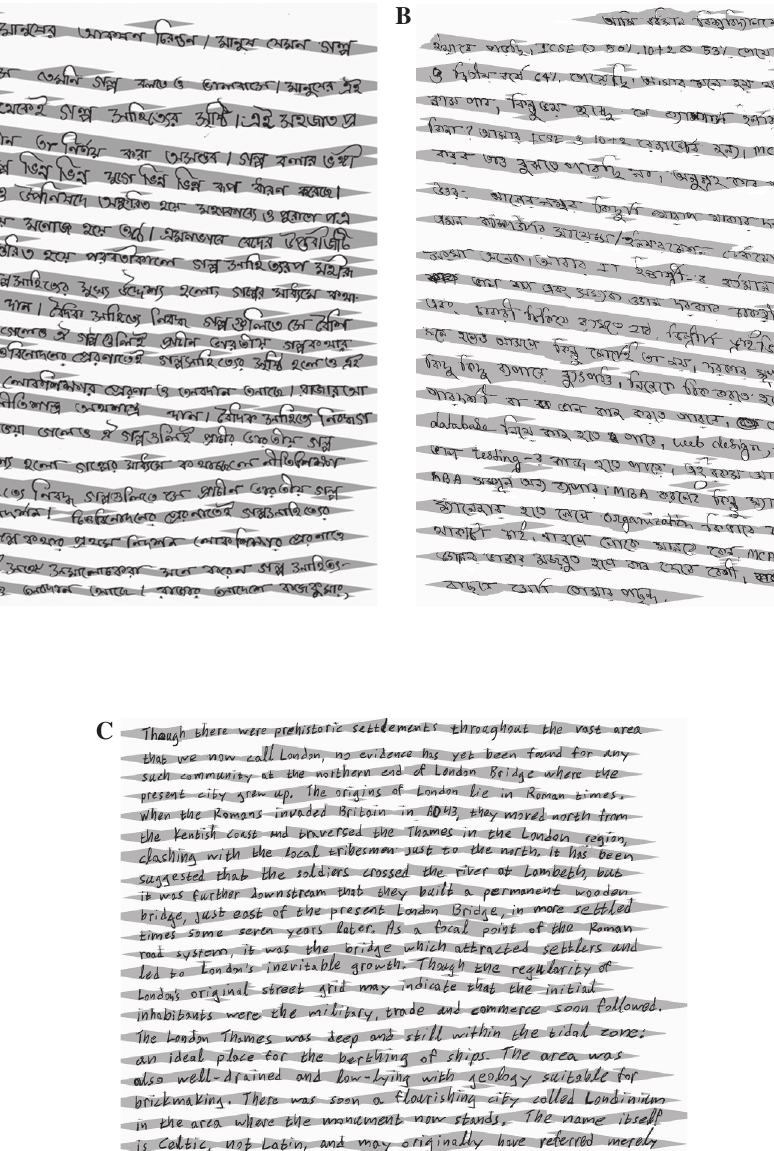
shows a sample document image where the technique [1] fails to extract some of the text lines from the document image, and Figure 11B shows the successful result on the same document using the current methodology.